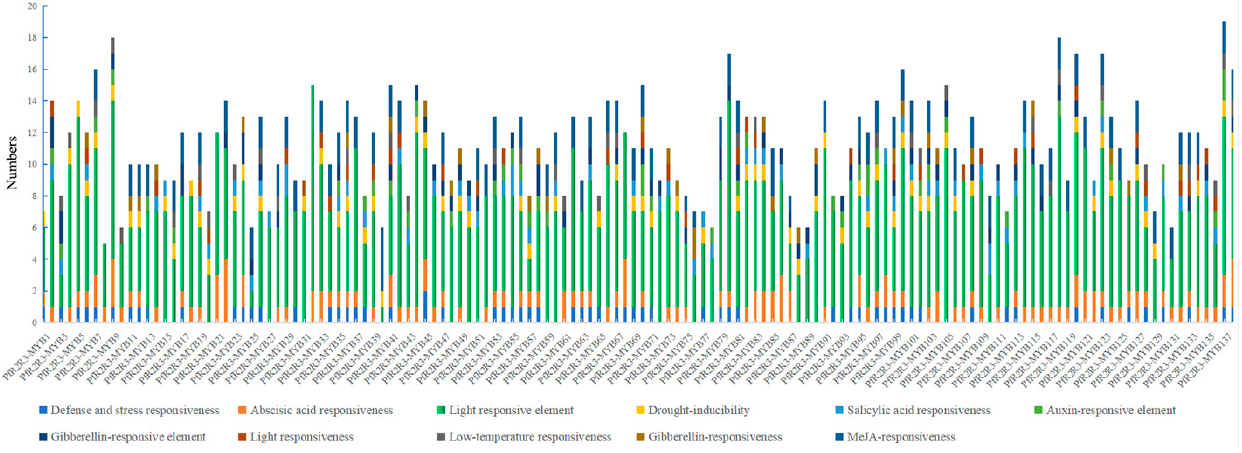
Figure 4. Cis -regulatory elements analysis of PfR2R3-MYB genes. Each cis -regulatory element type was marked by different colored boxes. Number of cis -regulatory elements in the promoter regions of PfR2R3-MYB genes.